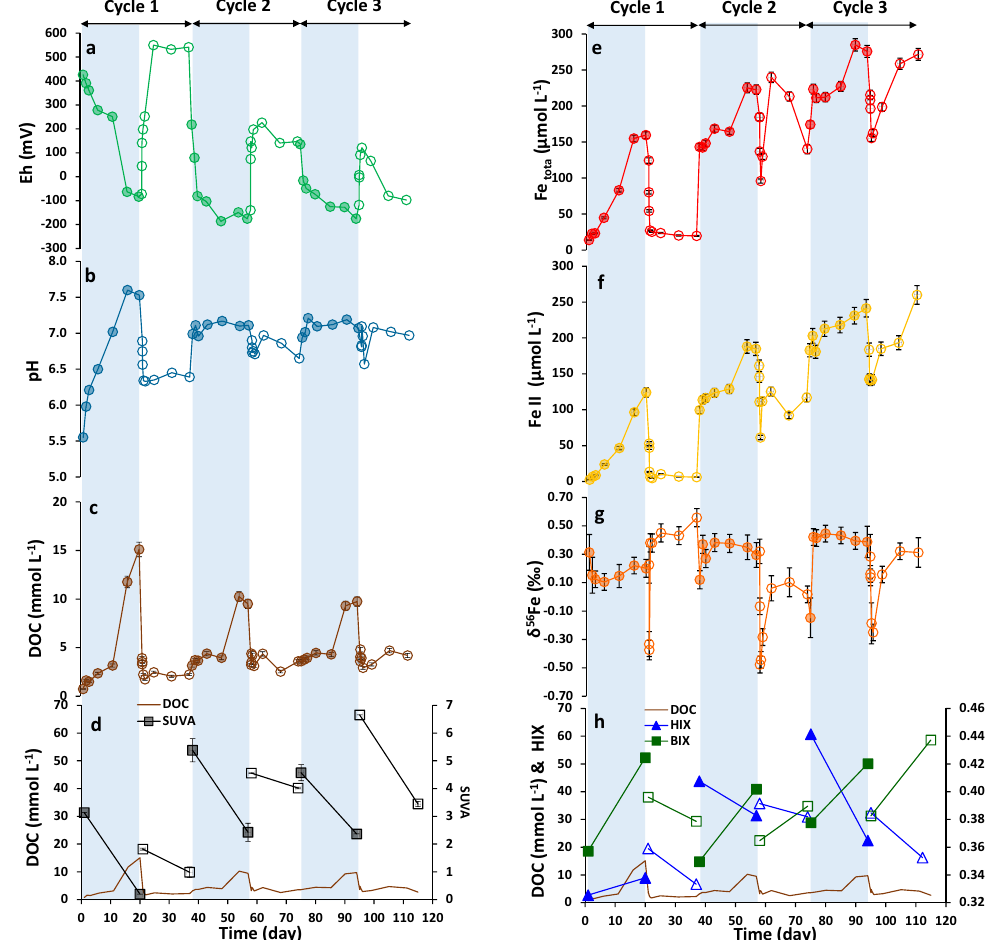
Figure 1. Evolution of Eh ( a ), pH ( b ), DOC ( c ), SUVA ( d ), Fe tot ( e ), Fe(II) ( f ), δ 56 Fe ( g ) and the BIX and HIX indexes ( h ) versus time (day) during the anoxic/oxic cycles. Eh and pH were measured in the soil suspension and other parameters were determined in filtrates of 0.2 µm. The blue zones illustrate the anoxic periods and the white ones the oxic periods. The filled and empty symbols correspond to samples under anoxic and oxic conditions, respectively. Analytical error bars were calculated by (i) measuring the standard for DOC, Fe(II) Fe tot , and δ 56 Fe (2SD) analyses, (ii) average of Replicates analyses (n = 2 or 3) for SUVA, and (iii) Eq. (3) if there were replicates of